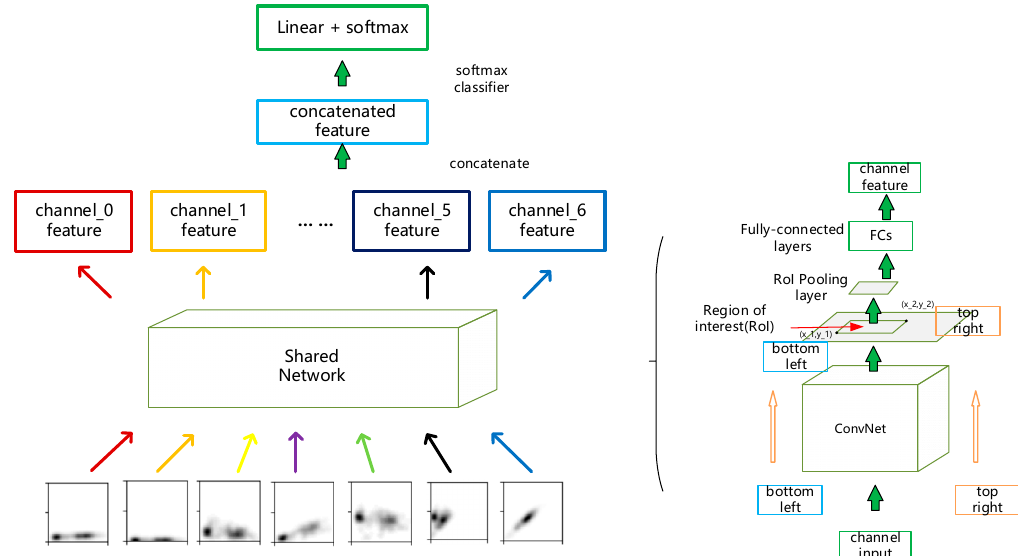
Figure 7. The structure of the inference network.